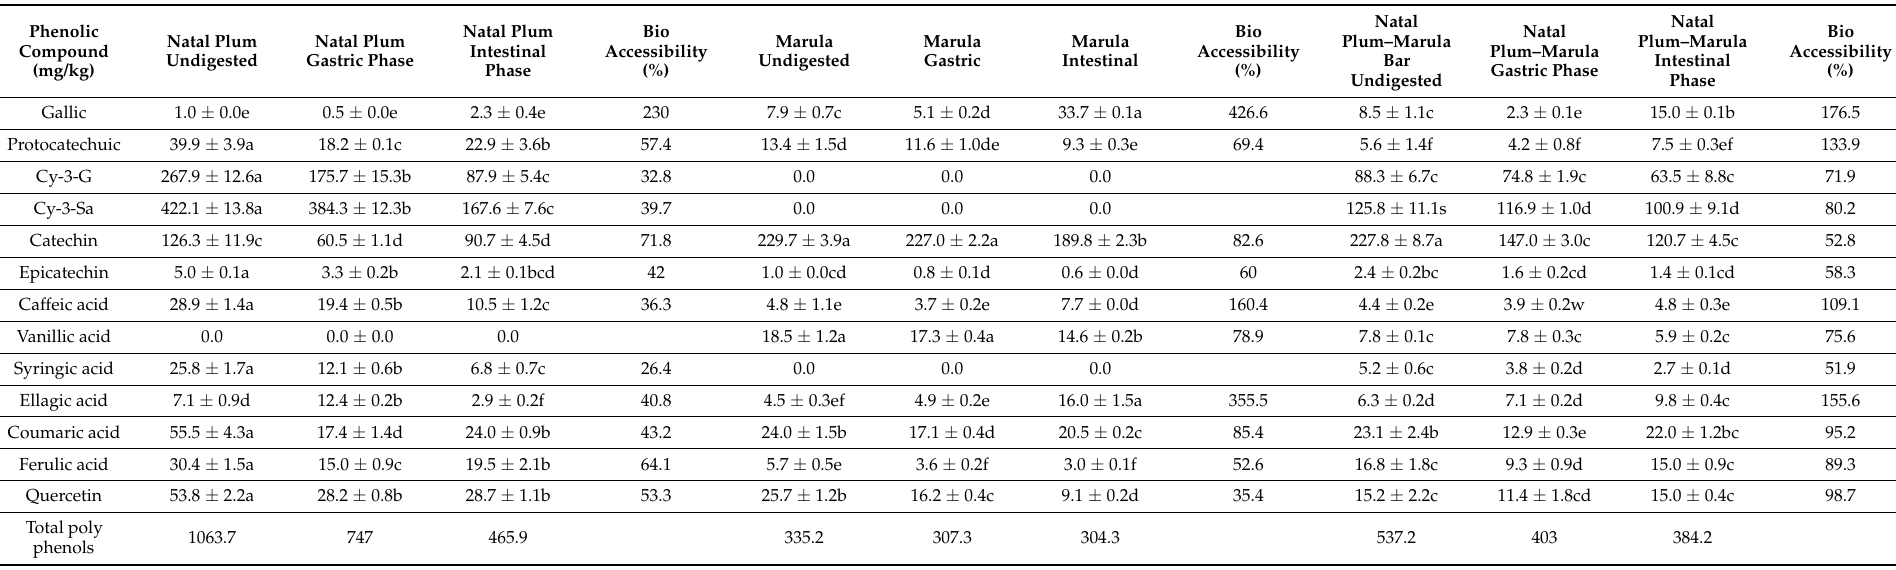
Table 1. Changes in bioaccessibility of anthocyanins and other polyphenols after simulated co-digestion of Natal plum and Marula nut in a bar on fresh weight